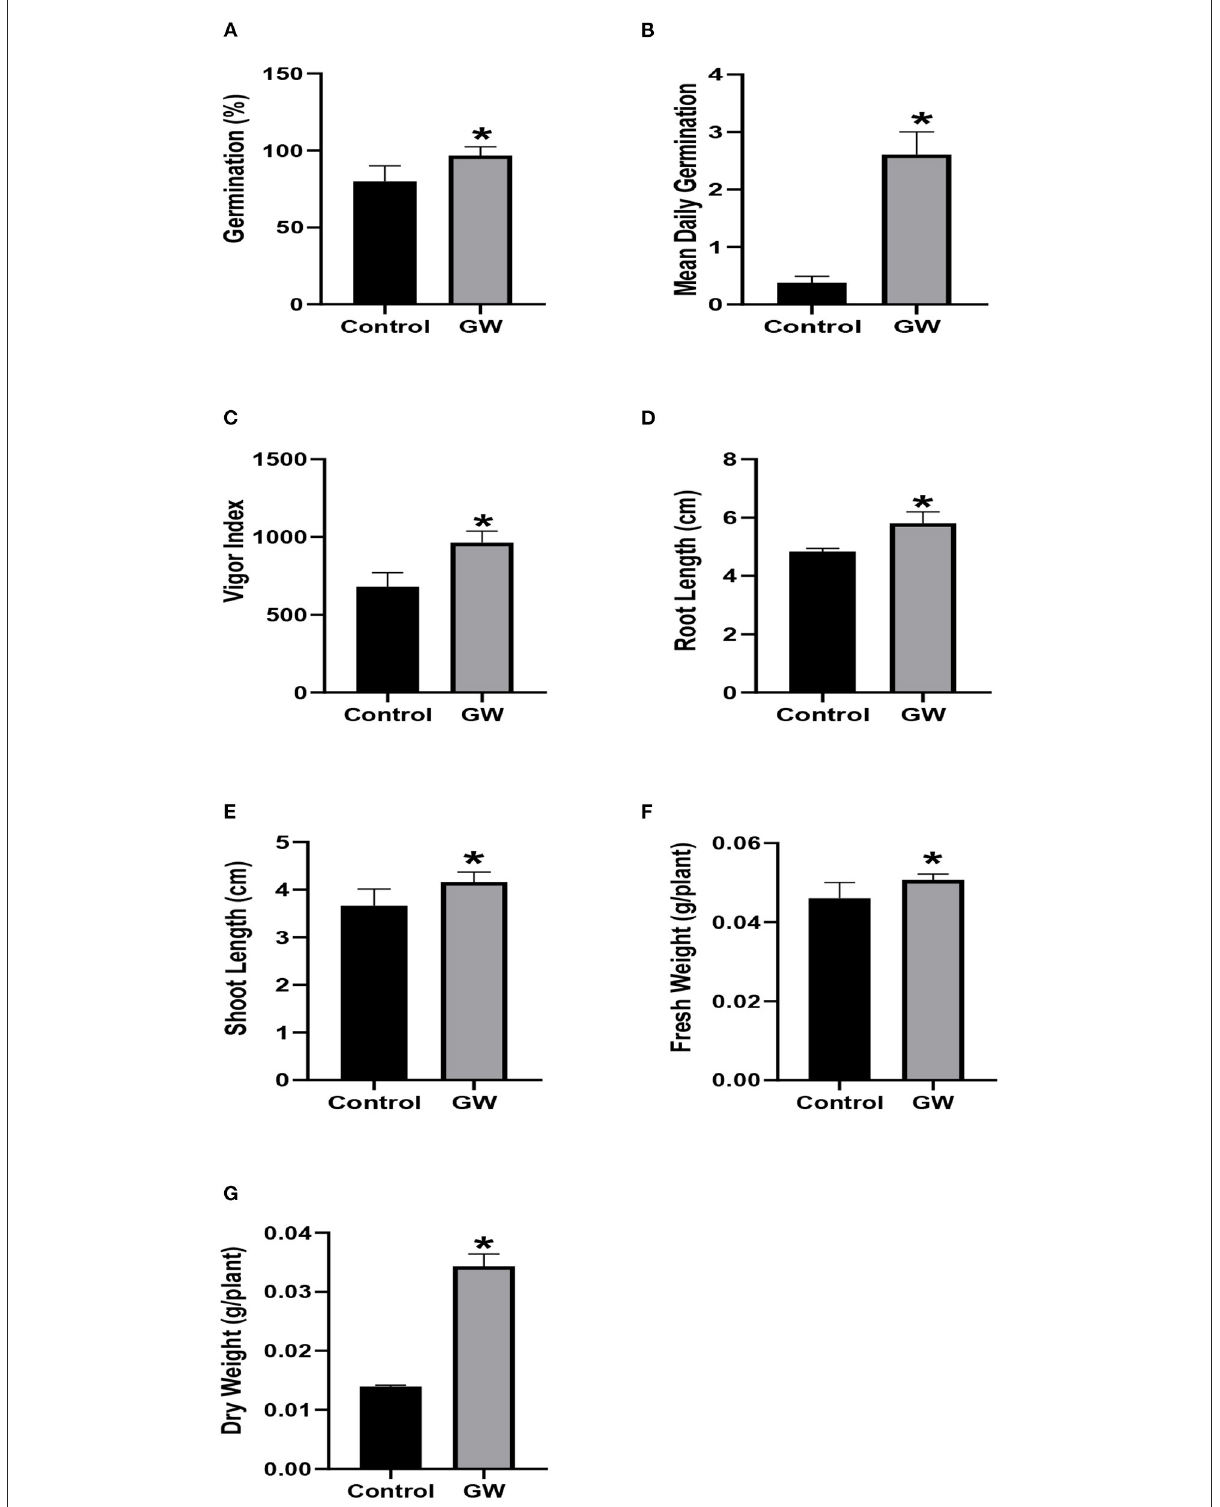
FIGURE3 Effect of FCF from endophytic fungus F. oxysporum GW on the germination (A) , mean daily germination (B) , Vigor index (C) , root length (D) , shoot length (E) , fresh weight (F) , and dry weight (G) of wheat seedlings for 1 week after germination. Bars show the mean of three replicates with standard deviation. Bars labeled with * are significantly higher ( t -test; p <